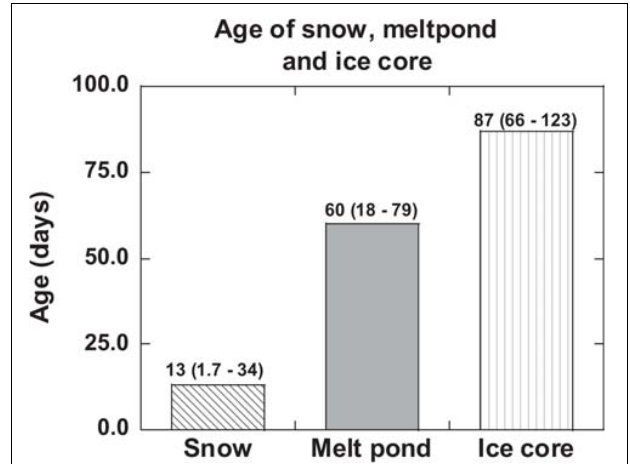
FIGURE 4 | 210 Po: 210 Pb-disequilibrium-based age/residence time of snow, melt pond ice core and compared to the residence time of surface ocean water. The mean values are given and numbers in parenthesis denote the range (US GEOTRACES Arctic cruise, HLY 1502, R/V Icebreaker USCGC